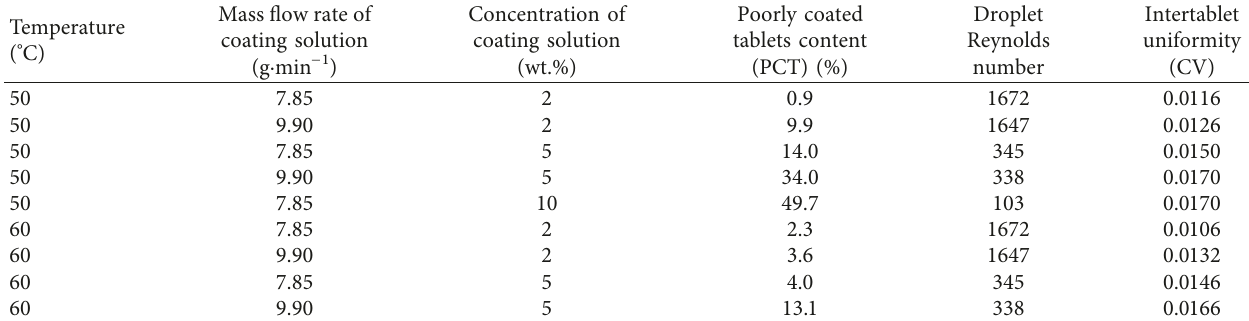
Table 6: Preliminary results